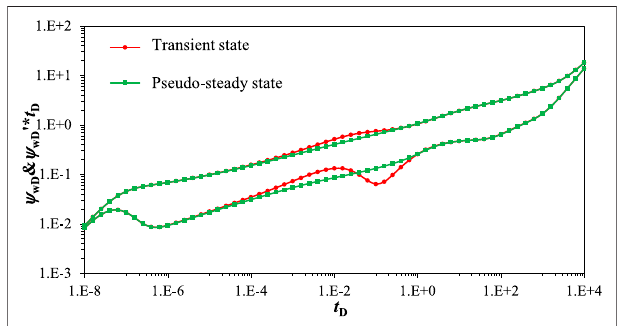
FIGURE 14 | Pressure transient response curve effected by adsorption desorption coef fi cient. ( C D = 1e-5, S = 0.01, x asymD = 0.3, L F = 150 m,